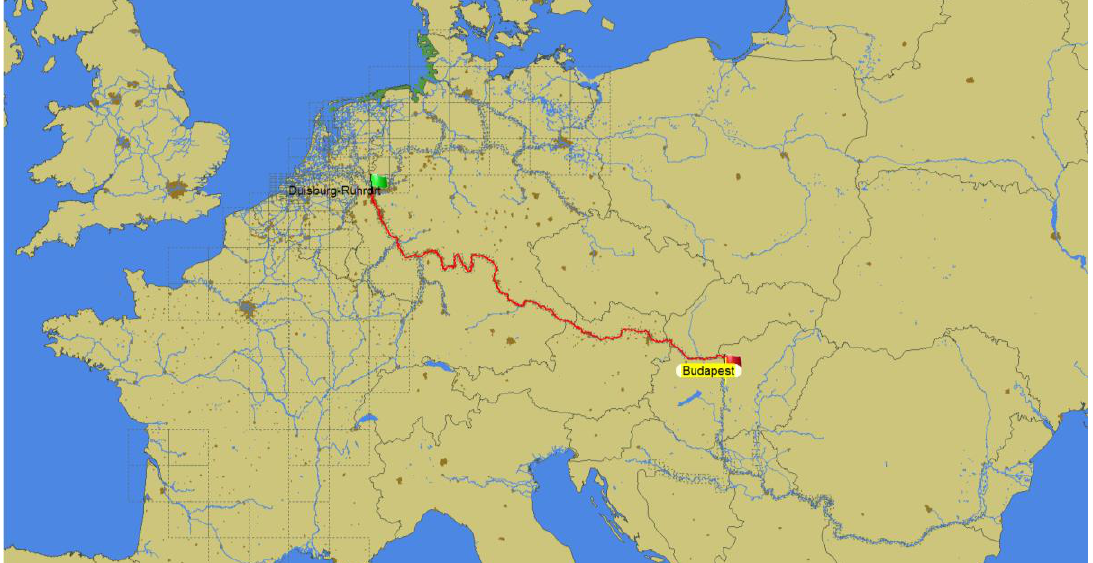
Figure 1. Concerned waterway route from Budapest to Duisburg Source: PC-Navigo route